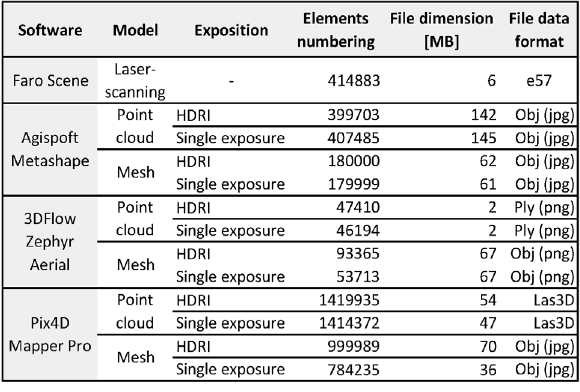
Figure 10. 3D laser scanning and photogrammetric model data